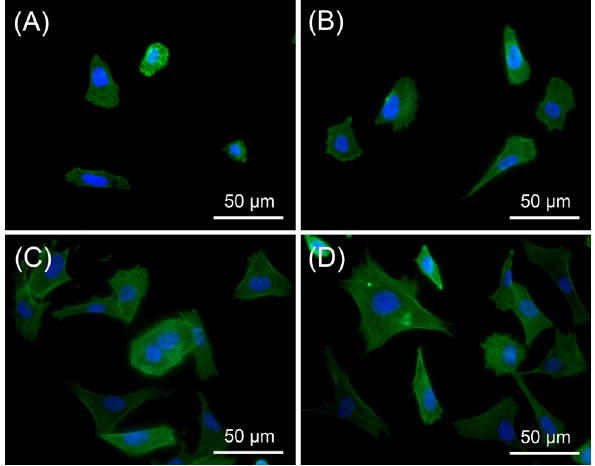
Figure 4. Fluorescent microscopy images of MG63 cells on ( A ) Control; ( B ) MP; ( C ) COL; ( D ) MP/COL (actin cytoskeleton (green)—Alexa 488, nucleus (blue)—DAPI).